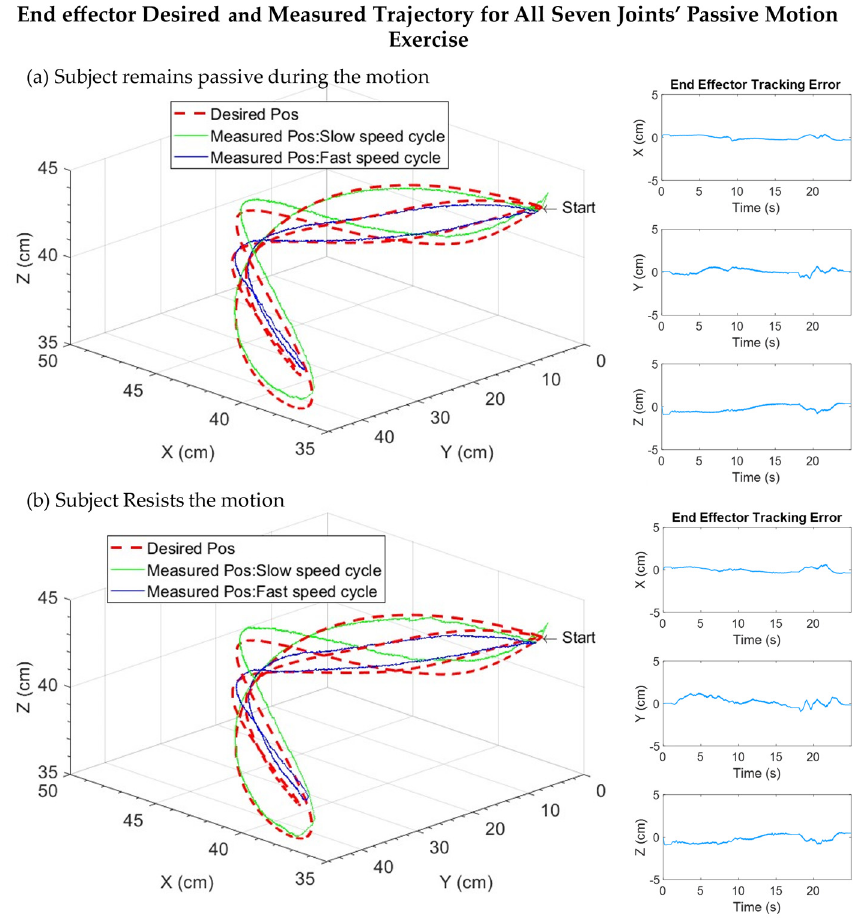
Figure 12. Cartesian trajectories and errors for all seven joints’ passive exercise for Subject D.